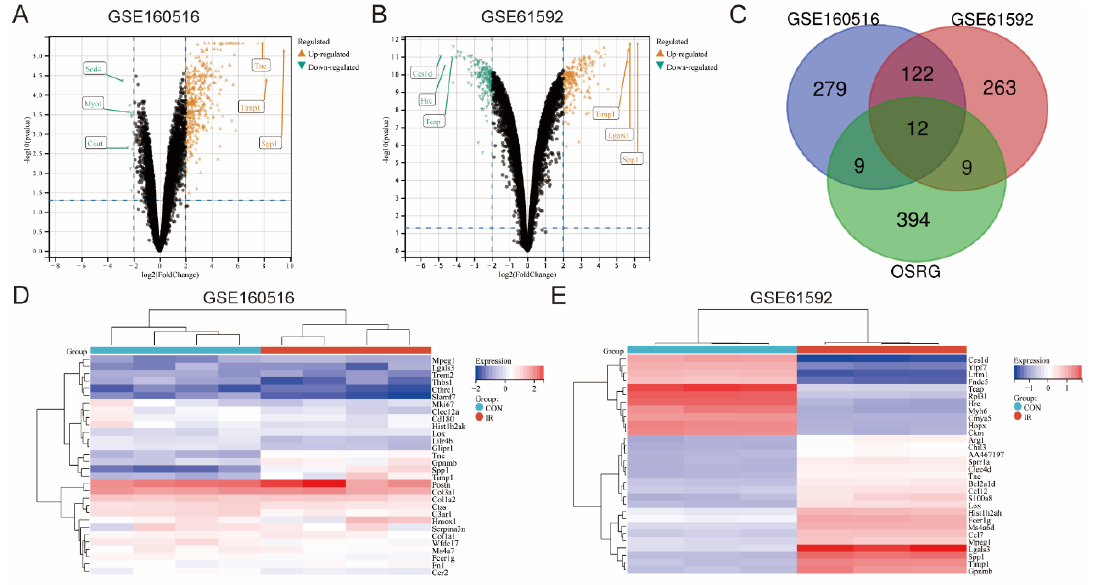
Figure 1. Identification of DEGs and differentially expressed OSRGs in myocardial ischemia–reperfusion injury. ( A ) The volcano plot of GSE160516. ( B ) The volcano plot of GSE61592. For (A,B), the blue dots in the upper ‐ left box are downregulated genes, the orange ‐ yellow dots in the upper ‐ right box are upregulated genes, and the black dots represent genes that are not significantly different. ( C ) Venn diagram of DEGs in GSE160516, GSE61592, and OSRGs in MSigDB. ( D ) Heatmap of the top 30 DEGs in GSE160516. ( E ) Heatmap of the top 30 DEGs in GSE61592.